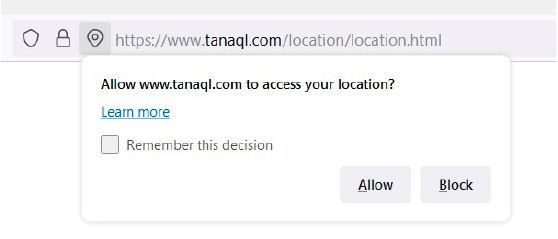
Figure 3. The permission in the W3C Geolocation